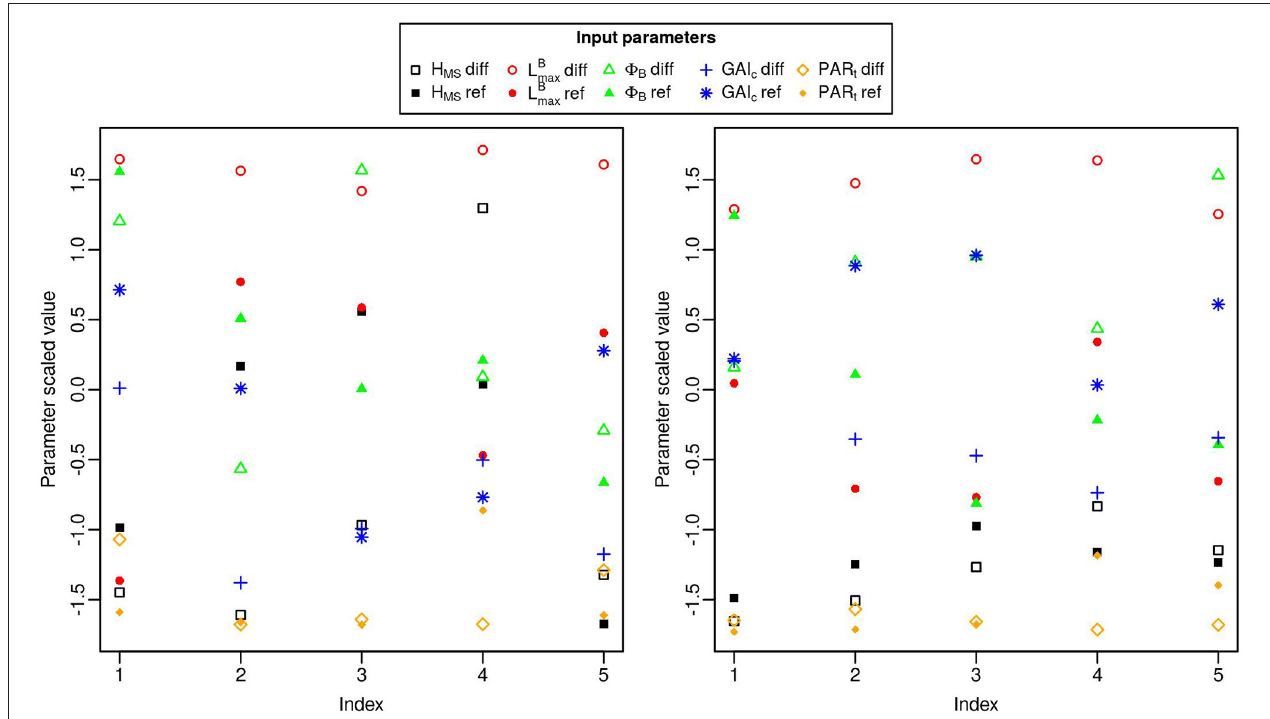
FIGURE 9 | Parameter values for the five simulations with the highest F tot in the initial design (left) and in the 50 simulations added by EGO (right). The x-axis is an indication of the ranking of the simulations based on the F tot values. Parameter values were scaled and centered so they could all be represented on the same axis. To avoid redundancy in the combinations of parameters, results are represented only with positive values of L B max